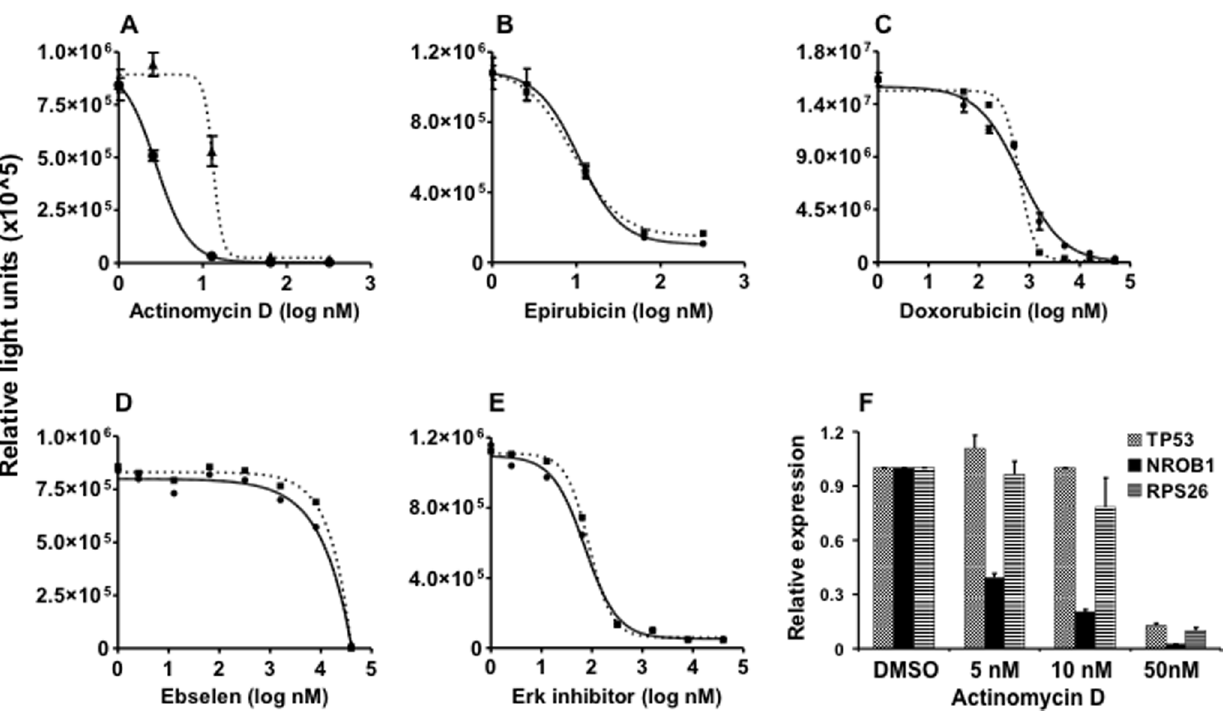
Figure 2. Effect of actinomycin D on gene expression. Effects of actinomycin D ( A ), epirubicin ( B ) doxorubicin ( C ), ebselen ( D ) and Erk inhibitor ( E ) on NR0B1-Luc (solid line) and UbC-Renilla (dotted line) reporter activity. Data plotted as mean + / 2 SEM of triplicates. F : Quantitative RT-PCR was used to determine the abundance of NR0B1, TP53 and RPS26 mRNA after overnight treatment of A673 cells with the indicated concentrations of actinomycin D. Results normalized to DMSO control. Data plotted as mean + / 2 SD of quadruplicates, and are representative of 3 independent experiments.